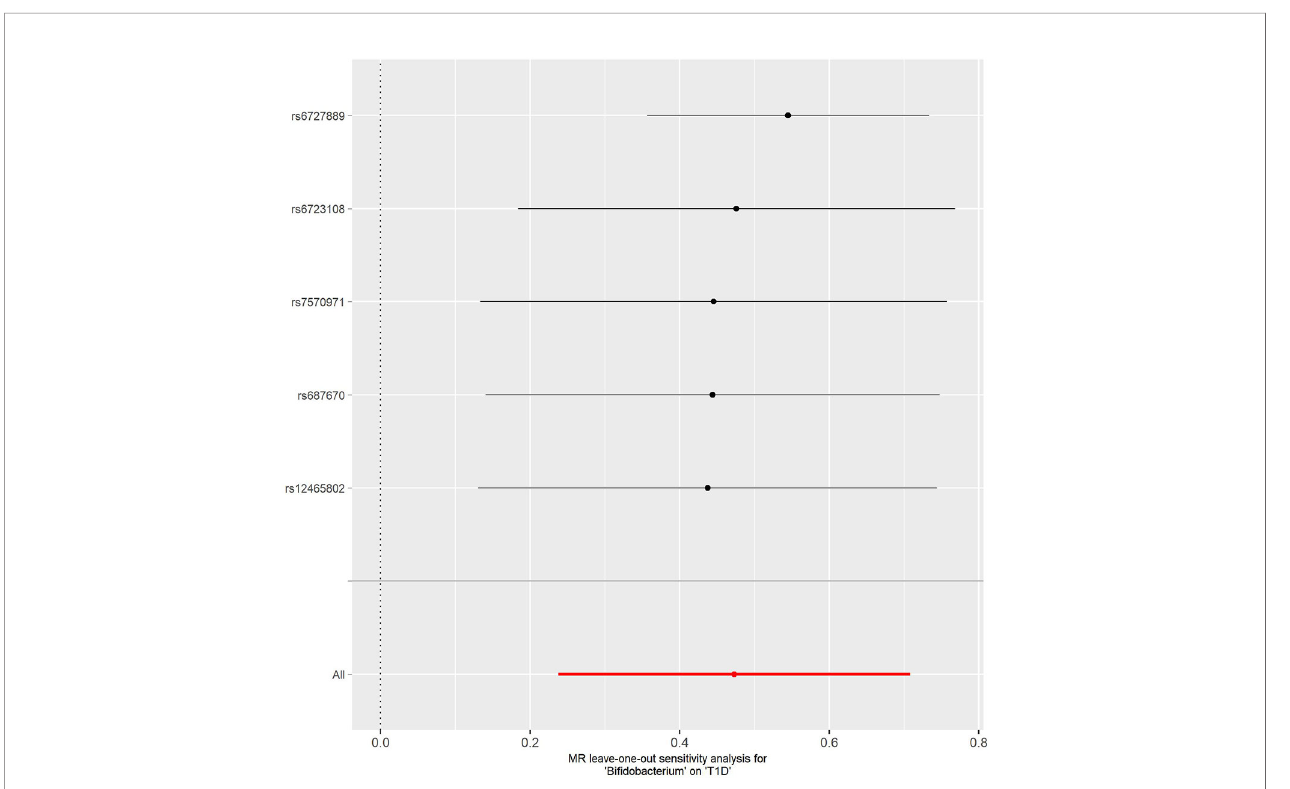
FIGURE 2 | Leave-one-out analysis of the causal effect of Bi fi dobacterium on T1D. Red lines represent estimations from the IVW test. T1D, type 1 diabetes; IVW, inverse variance weighted.